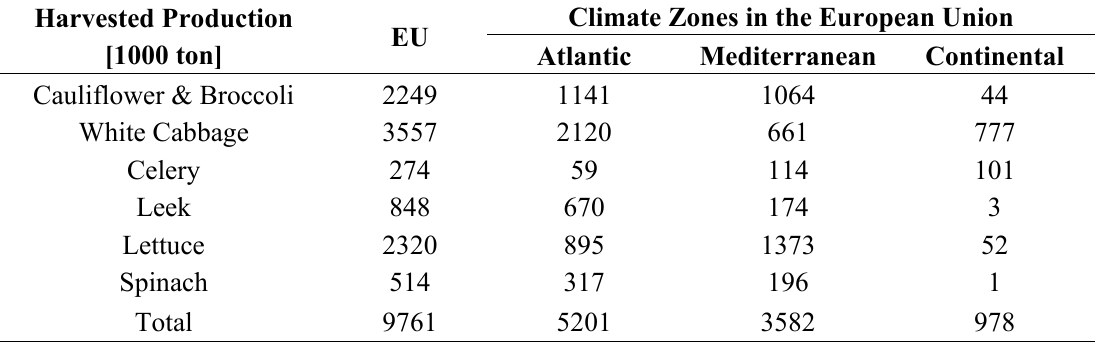
Table 1. Harvested production of open field vegetable crops in the European Union (EU) in 2012 [1].